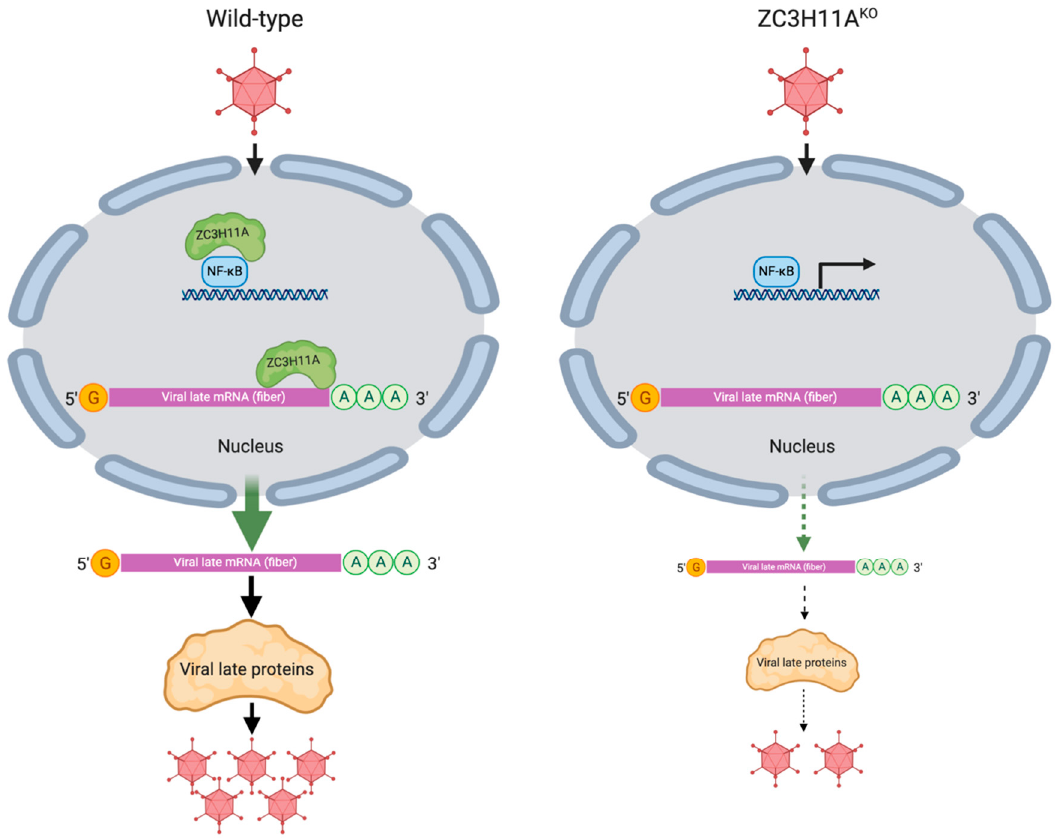
Figure 2. Proposed model of ZC3H11A pro-viral role in human adenovirus type 5 (HAdV-5) infected cells. Increased accumulation of the ZC3H11A protein promotes selective virus late mRNA (e.g., fiber mRNA) nuclear export during late phase of HAdV-5 infection (Wild-type). Lack of the ZC3H11A protein (ZC3H11A KO ) reduces HAdV-5 late mRNA nuclear export, virus late protein synthesis, and formation of infectious virus progeny. ZC3H11A interference with the NF- κ B signaling pathway prevents expression of pro-inflammatory genes, a block that is relieved in ZC3H11A KO cells. Figure created with Biorender.com.